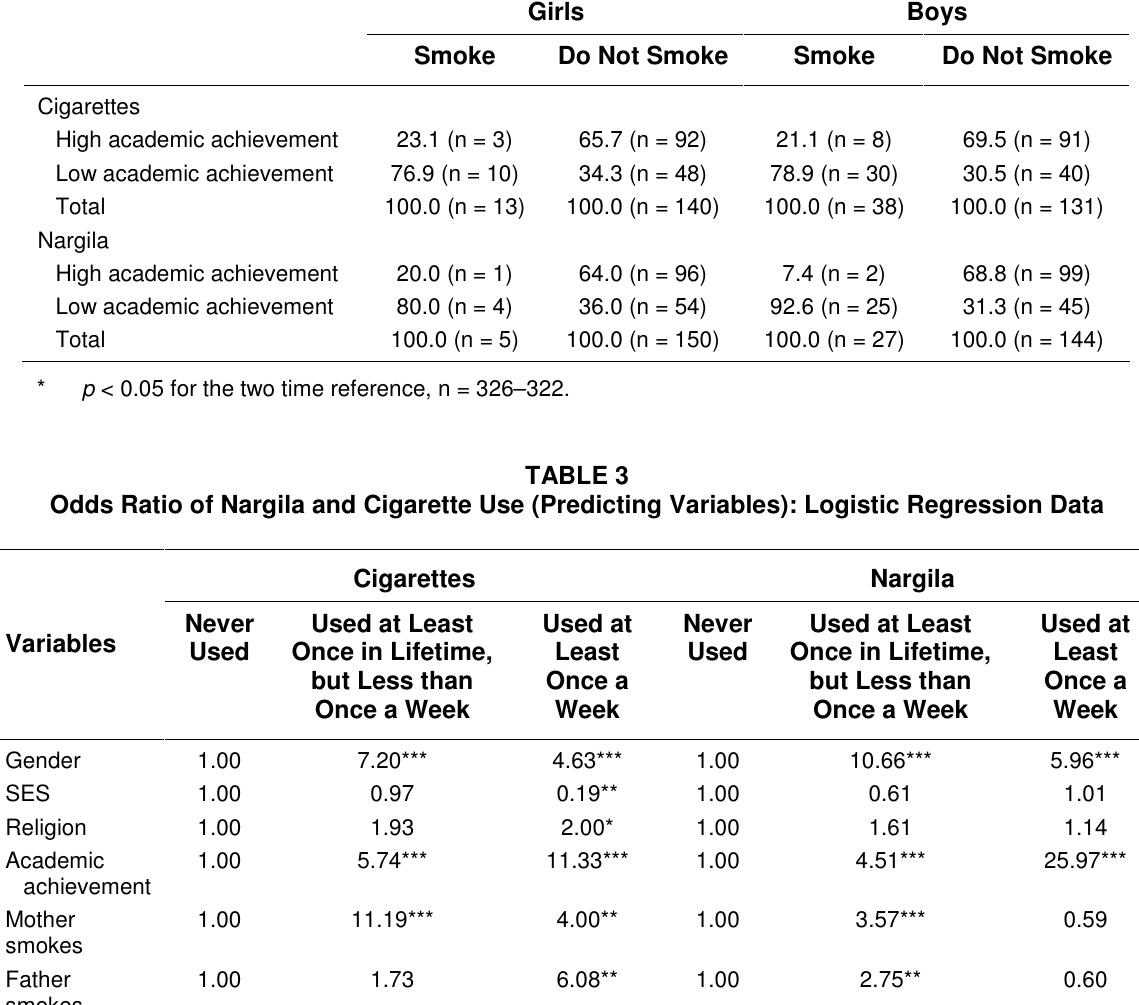
Percent Distribution of Cigarette and Nargila Smoking by Academic Achievement and Gender*